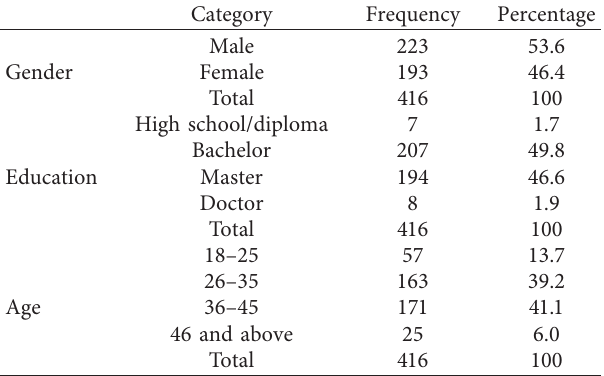
Table 4: Demographical